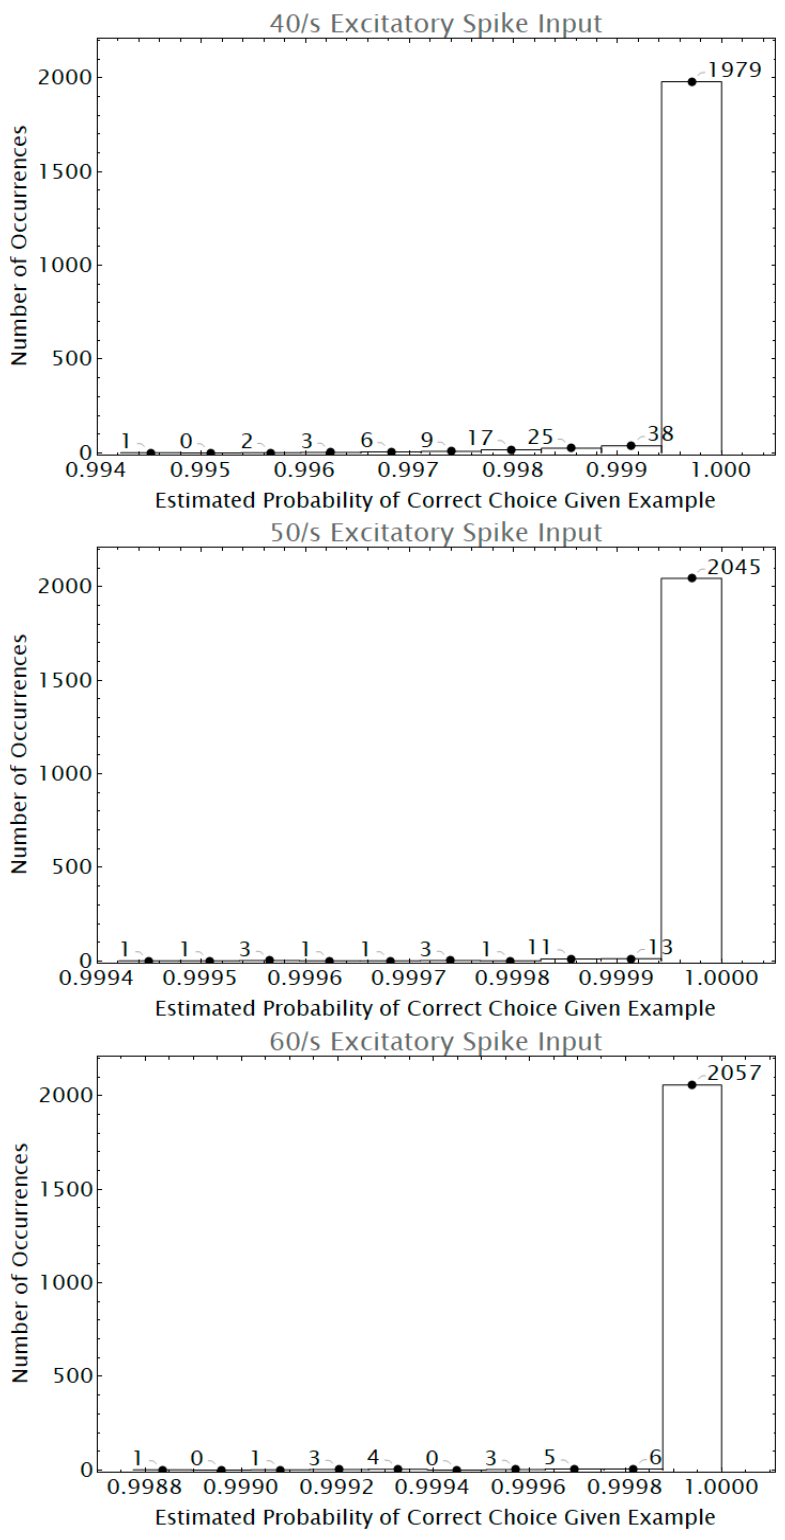
Figure 9. The frequency of occurrence of all posterior probability estimates for correct choices given each of the 2080 examples are shown for simulations in which the control parameter has values of 40/ s , 50/ s , and 60/ s . Bin widths are 5.7777 × 10 − 4 , 5.7943 × 10 − 5 , and 1.2255 × 10 − 4 from top to bottom.